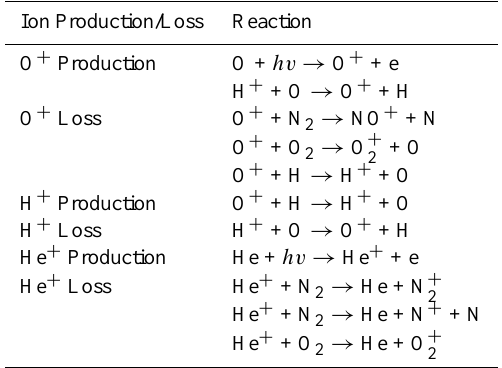
Table 1. The main production and loss reactions which determine the concentration of O + , H + and He + in the topside ionosphere Ion Production/Loss